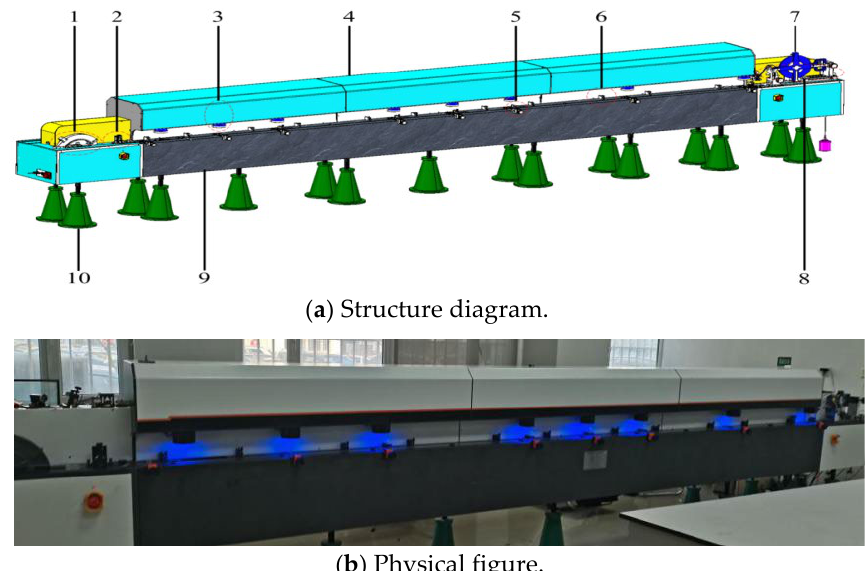
Figure 1. Steel measuring tape calibration device: 1. Tape-winding mechanism; 2. encoder counting mechanism; 3. machine vision system; 4. cover plate; 5. limit adjusting mechanism; 6. pressure bar mechanism; 7. tape retracting mechanism; 8. jig adjusting mechanism; 9. granite platform; 10. sup-